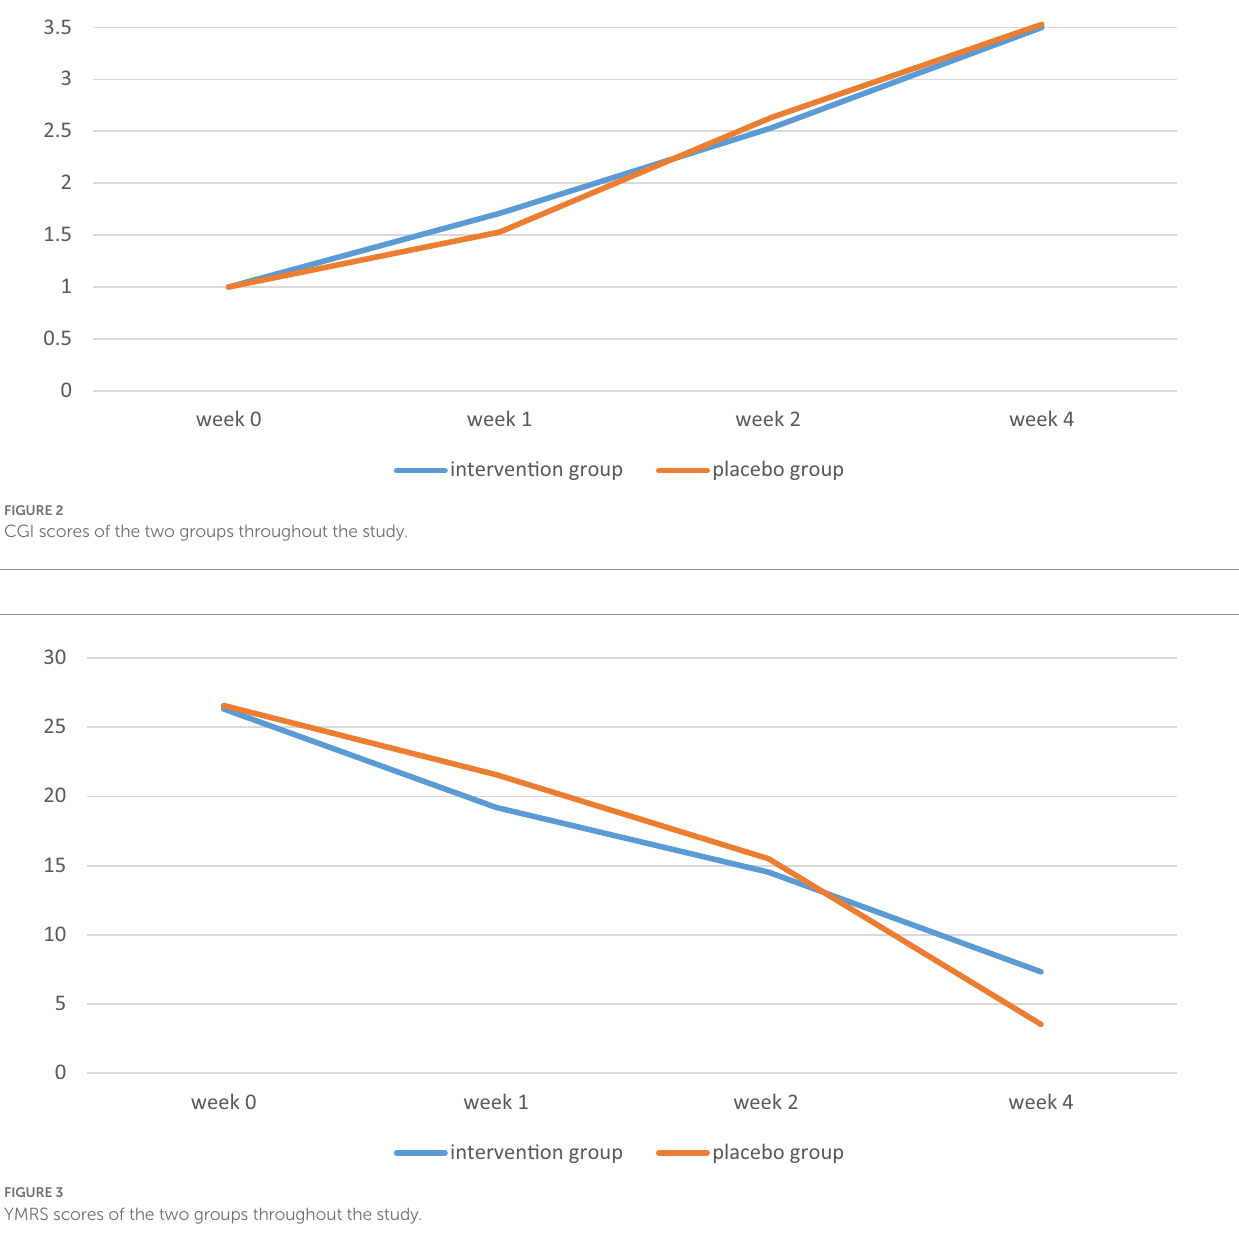
FIGURE 3 YMRS scores of the two groups throughout the